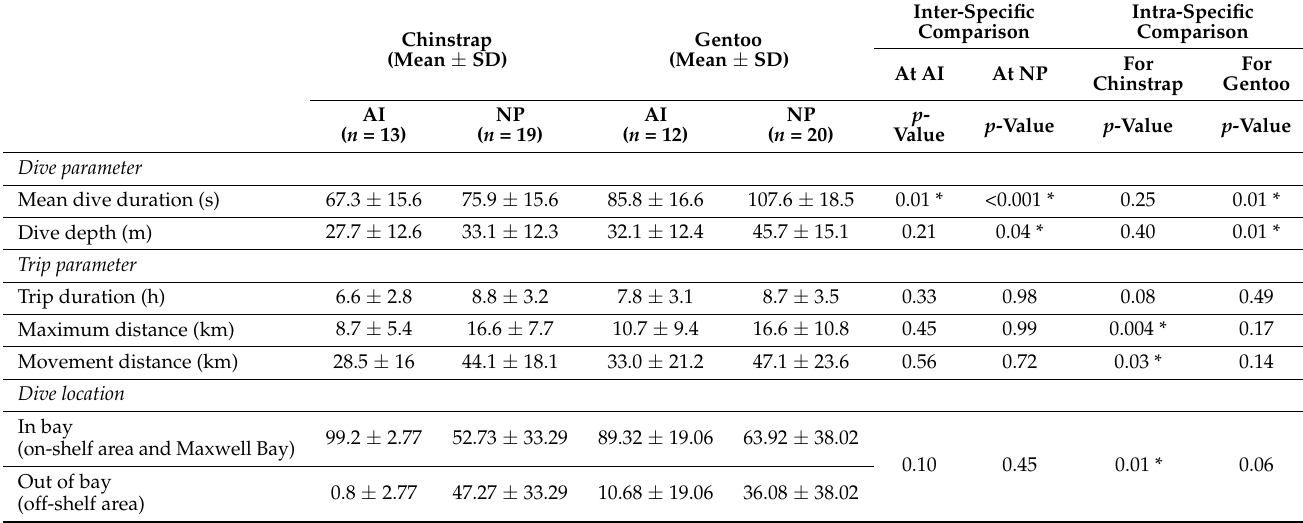
Table 2. Inter-specific and intra-specific comparisons for dive parameters (mean dive duration and dive depth) with generalized linear mixed models (GLMMs) and for trip parameters (trip duration, maximum distance, and movement distance) and dive location (in bay or out of bay) with generalized linear models (GLMs). * indicates significant differences ( p < 0.05).